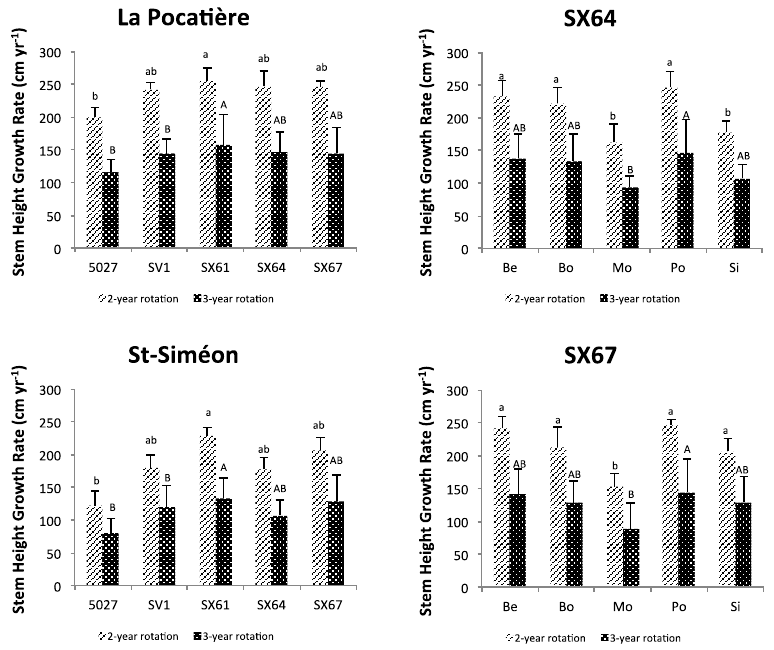
Figure 3. Stem height growth rates of willow stems under different rotation cycles. Values are means ( n = 9; SD on the top of each bar) for each site (Be = Beloeil; Bo = Boisbriand; Mo = La Morandière; Po = La Pocatière, Si = St-Siméon) and cultivar. A 5% significance level was adopted for identifying significant treatment effects according to Tukey’s HDS test. Lowercase letters were used to highlight significant difference in two-year rotation Capital letters identify significant differences in the three-year rotation.